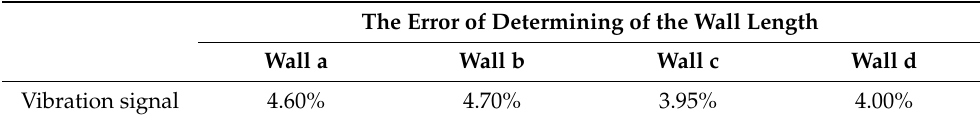
Table 6. The errors of determining the tetrahedron (Figure